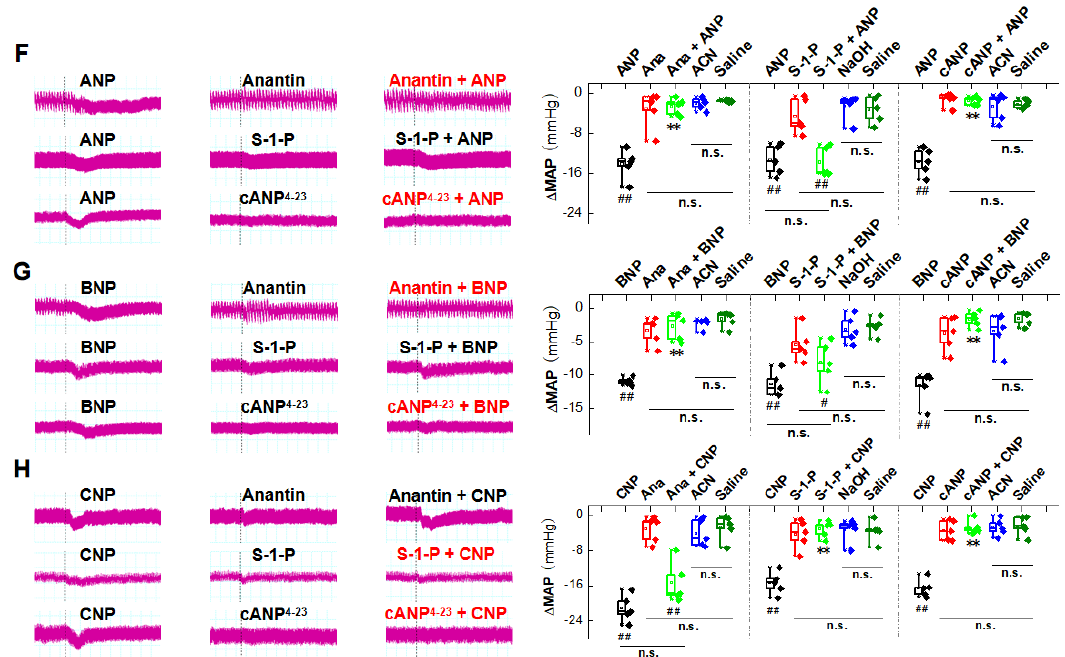
Figure 1. Natriuretic peptides (NPs)—mediated blood pressure (BP) reduction by nodose ganglion (NG) microinjection under physiological condition. ( A ) Real-time monitoring of mean arterial pressure (MAP) changes with the dotted line as the starting point of administration (ANP 1 mg/mL, saline solution, 3 µ L). ( B ) Quantitative analysis of BP changes (the difference between nadir after NPs injection and initial MAP). Averaged data was presented as mean ± SD. ** p < 0.01 vs. male rats; ## p < 0.01 vs. female rats; ∆∆ p < 0.01 vs. saline-injection control rats; n = 5–8, from 6 rats for male and female group, and 5 rats for the OVX group. ( C ) Effects of different concentrations of ANP (1 mg/mL, 3 µ L) microinjection in the male rats. Averaged data was presented as mean ± SD. * p < 0.05, ** p < 0.01 vs. male rats, # p < 0.05, ## p < 0.01 vs. female rats, n = 5 rats for each group. ( D , E ) Dose-response curve of ANP microinjection. EC 50 values were calculated in male, female, and ovariectomized (OVX) rats. Averaged data were presented as mean ± SD. ( F – H ) NG microinjection was performed in male group. ANP/BNP/CNP 1 mg/mL, saline solution; anantin 1 mg/mL, ACN solution; cANP 4–23 1 mg/mL, ACN solution; S-1-P 4 mg/mL, NaOH solution; ACN 0.2 mg/mL, saline solution; and NaOH 0.3 mmol/L, saline solution; 3 µ L, respectively. Effects of NPRA inhibitor: Anantin, NPRB inhibitor: S-1-P, and NPRC activator: cANP 4–23 on the functions of ANP, BNP, and CNP, respectively. The representative bands of MAP fluctuation monitored in real time were shown on the left. Summarized data of microinjection was shown on the right. Averaged data was presented as mean ± SD. ** p < 0.01 vs. NPs-injection group, # p < 0.05, ## p < 0.01 vs. saline-injection control group, n.s., no significant difference. n = 5 rats for each